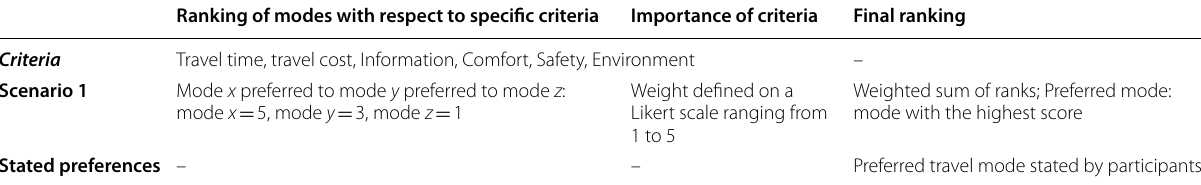
Table 1 Construction of mode preference from the survey Ranking of modes with respect to specific